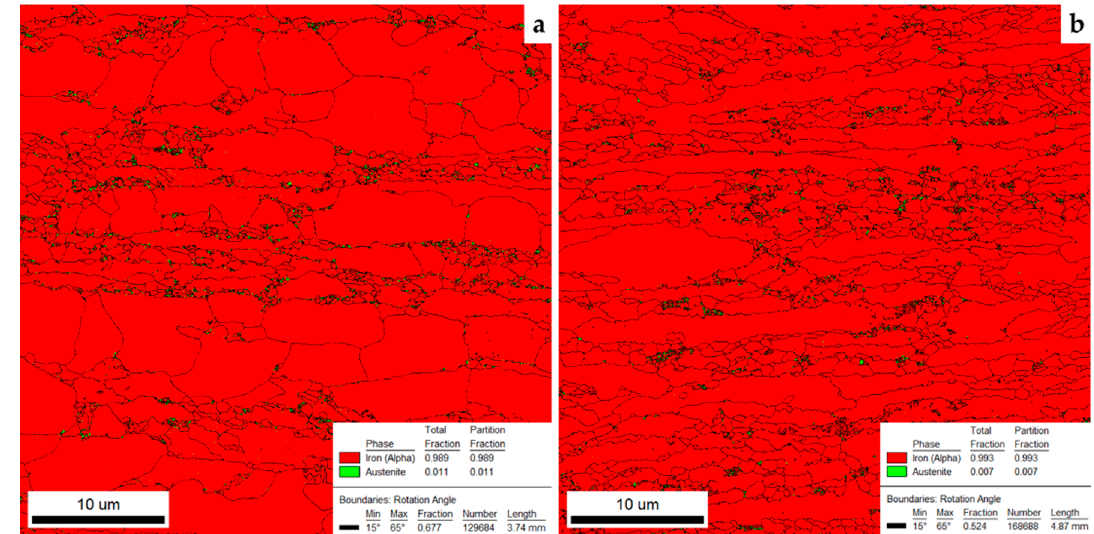
Figure 7. ( a ) Phase map of the CH sample, which contained 1.1% austenite, ( b ) phase map of the UFH sample in which the amount of austenite was 0.7%.